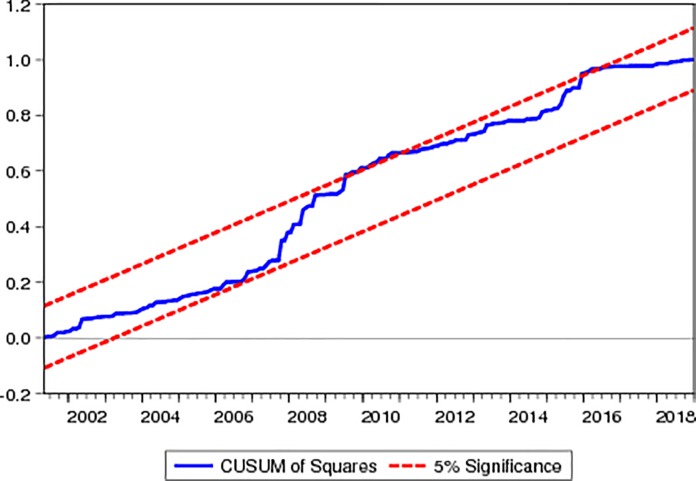
CUSUM of Squares.